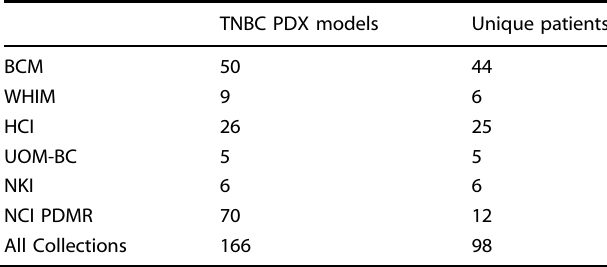
Table 2. PDX Summary statistics. Table 3. Matched patient summary